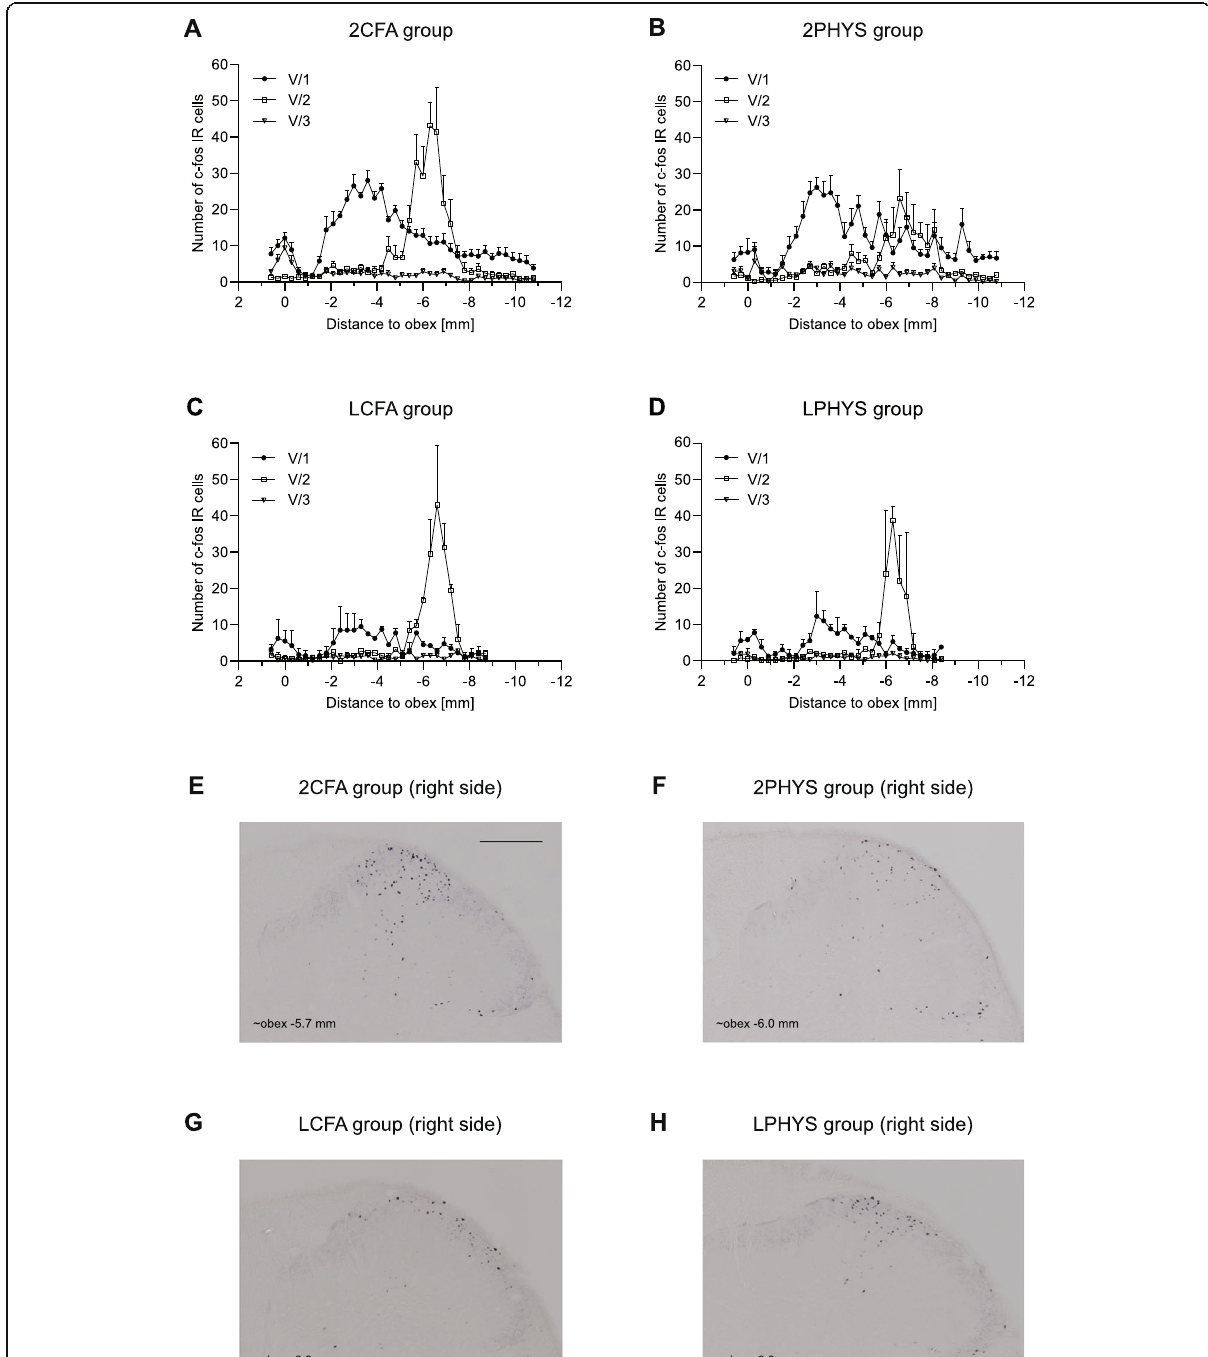
Fig. 3 Diagrams illustrate mean number of c-Fos IR neurons in the dorsal horns 2 h after CFA treatment. The number of the cells is displayed according to somatotopic representation of V/1, V/2, V/3 in 2CFA a and 2PHYS b groups. Diagrams show the mean number of c-Fos IR cells in LCFA c and LPHYS d groups. Representative photomicrographs from 2CFA e , 2PHYS f , LCFA g , LPHYS h group showing the right dorsal horns. Scale bar: 200 μ m. Lidocaine decreased the number of c-Fos positive cells compared to 2CFA and 2PHYS group especially in the V/1 area of the dorsal horns (mean+